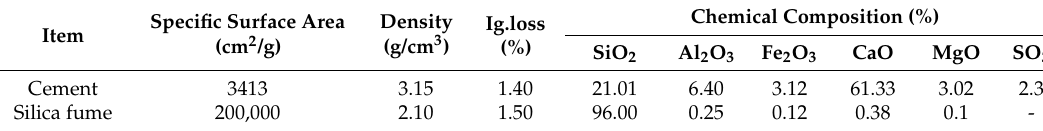
Table 1. Physical and chemical properties of cement and silica fume.